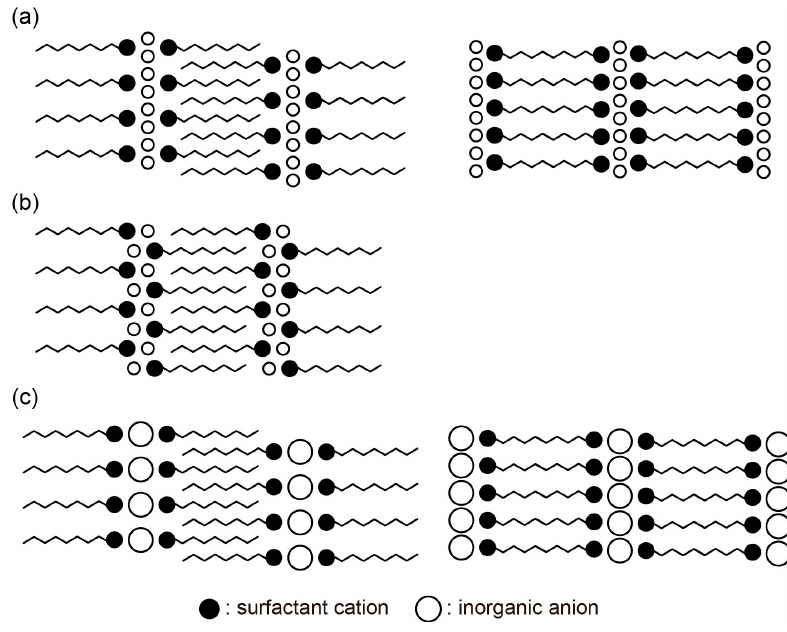
Figure 8. Packing manners observed in the hybrid surfactant single crystals comprised of discrete inorganic anions: ( a ) Monomeric anions hybridized with single-headed surfactant (left) and double-headed surfactant (right); ( b ) monomeric anions to form bilayer arrangement hybridized with single-headed and single-chained surfactant; ( c ) polymeric anions hybridized with single-headed surfactant (left) and double-headed surfactant (right). The inorganic layers depicted by open circles are sometimes polymerized to form infinite two-dimensional layers (see text).